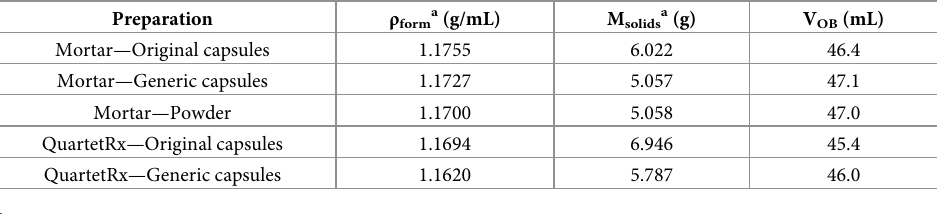
Table 3. Exact volume of Ora-Blend required to complete each preparation (50 mL) to achieve an HU final con- centration of 100